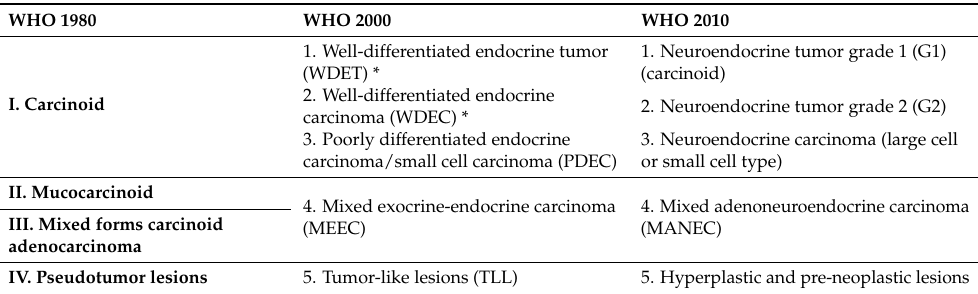
Table 1. Evolution in WHO terminology of neuroendocrine tumors of the digestive